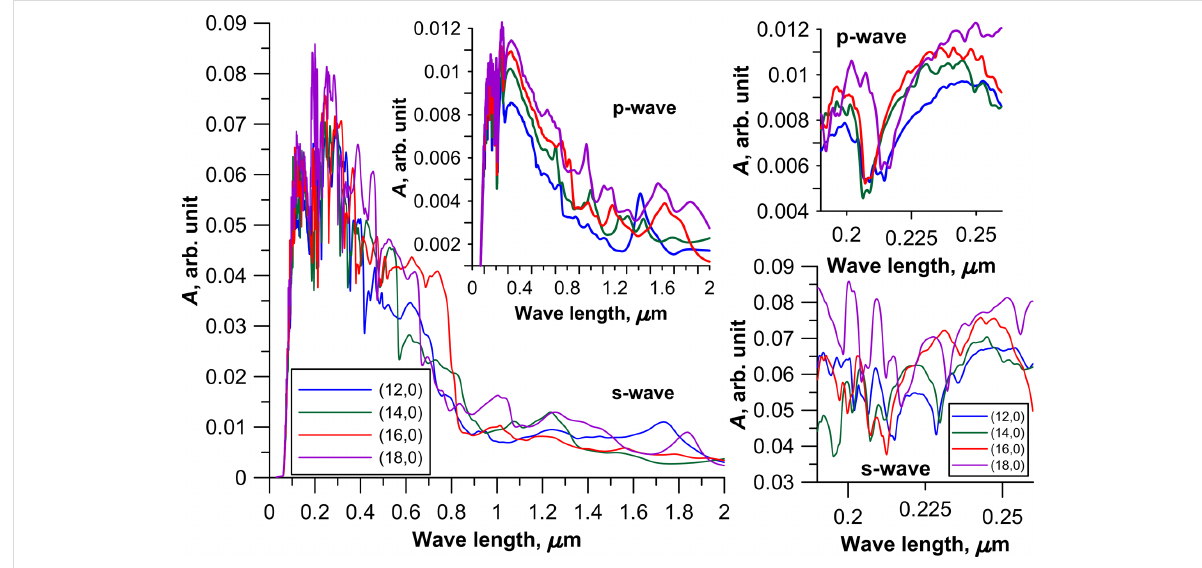
Figure 5: The absorption coefficient of 2D CNT–graphene hybrid nanocomposites with an intertube distance of 13 hexagons. The insets on the right side show the absorption coefficient for the wavelength range of 190–260 nm.